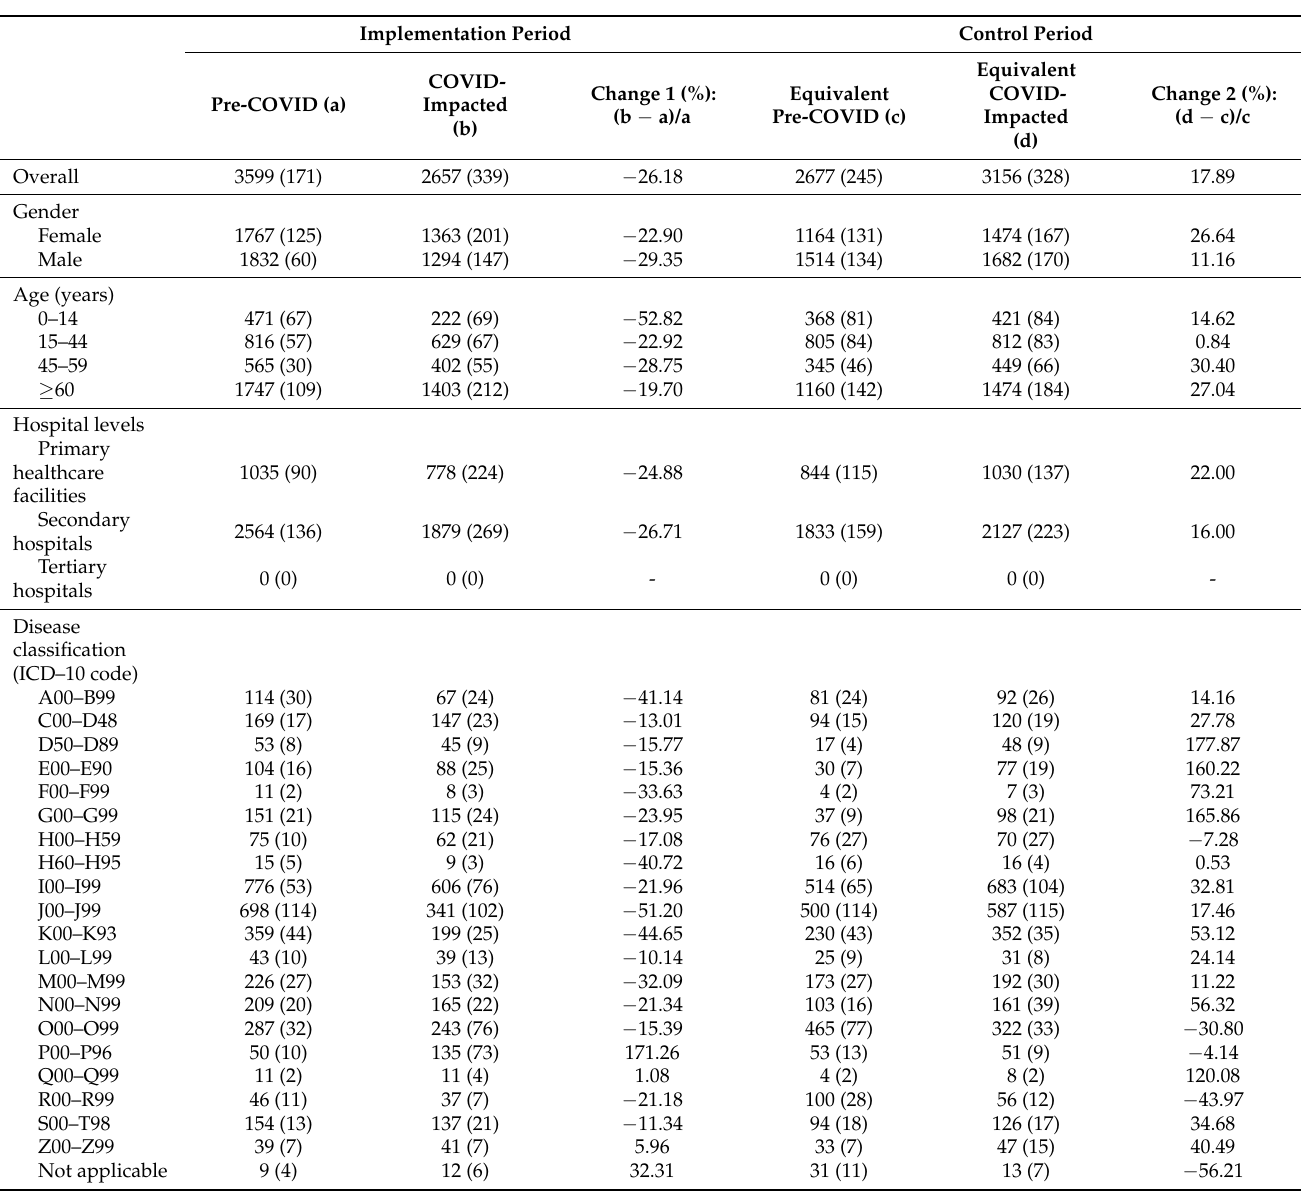
Table 1. Average monthly hospital visits in within-county areas for rural residents, shown as mean